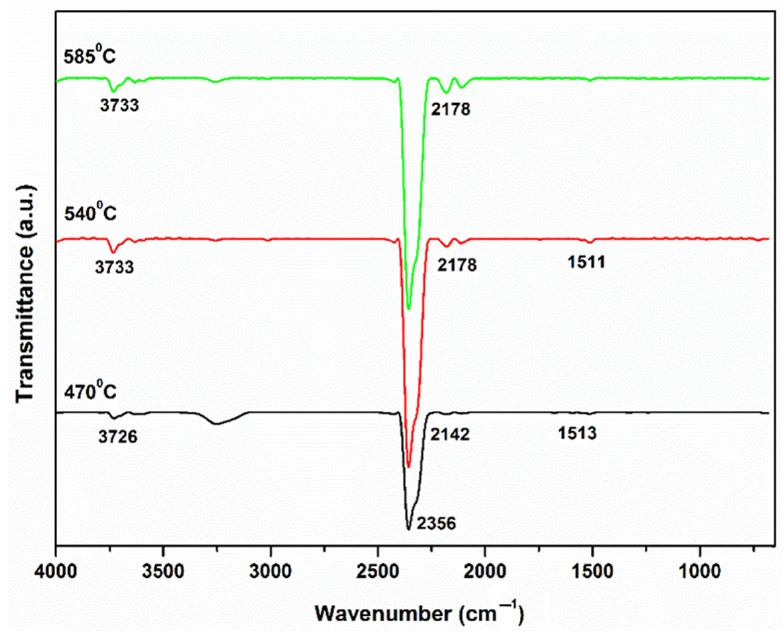
Figure 7. FTIR spectra for PEI-2 at various temperatures for thermal decomposition in air.